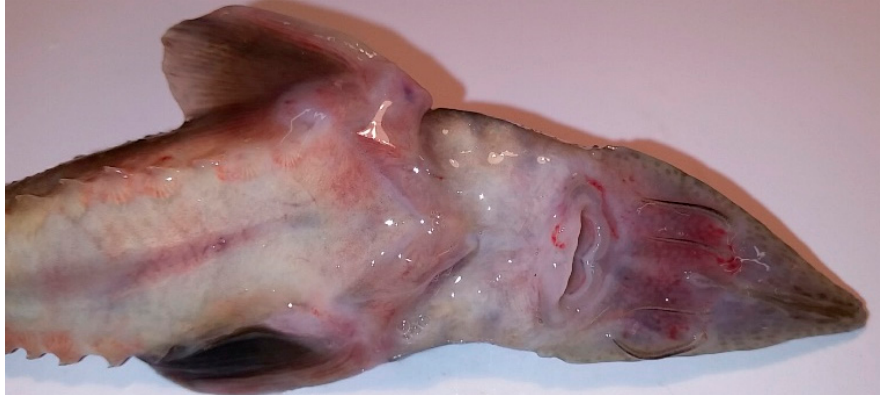
Figure 1. Siberian sturgeon with multiple haemorrhages (farm 5).